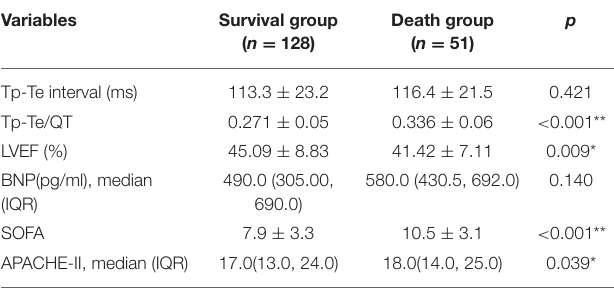
TABLE 4 | Comparison between the survival group and the death group. Variables